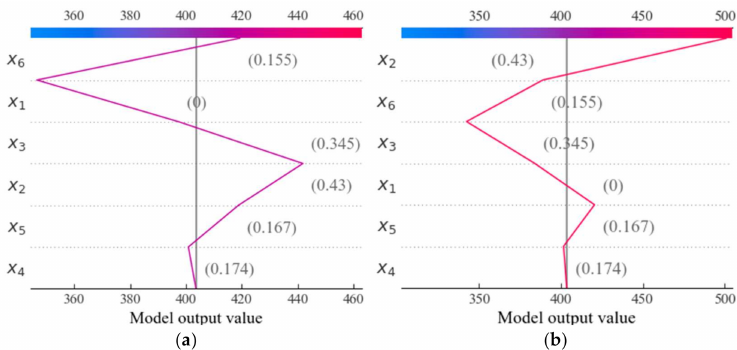
Figure 10. Individual interpretations for selected samples. ( a ) Sample 1: Specimen G (1.6) 30/20; ( b ) Sample 2: Specimen G (1.6)